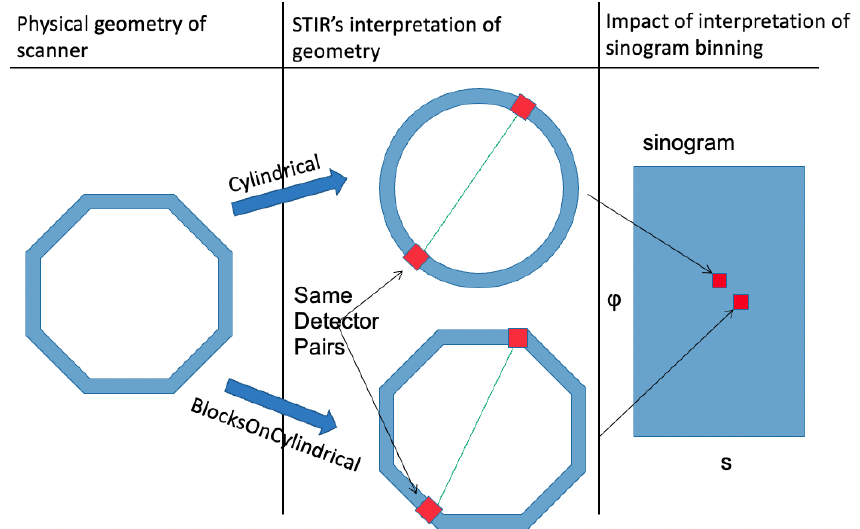
Figure 1. An illustration of STIR’s new class using one LOR. First column is the physical geometry of the scanner. Second column is STIR’s interpretation of such geometry using different geometry class: top is “Cylindrical” class, bottom is “BlocksOnCylindrical” class. Each class interprets each LOR from the same detector pairs differently due to different positions of the detector pairs. The difference in the position of the detector pairs causes the calculation of the LOR to be different in both ( s , φ )